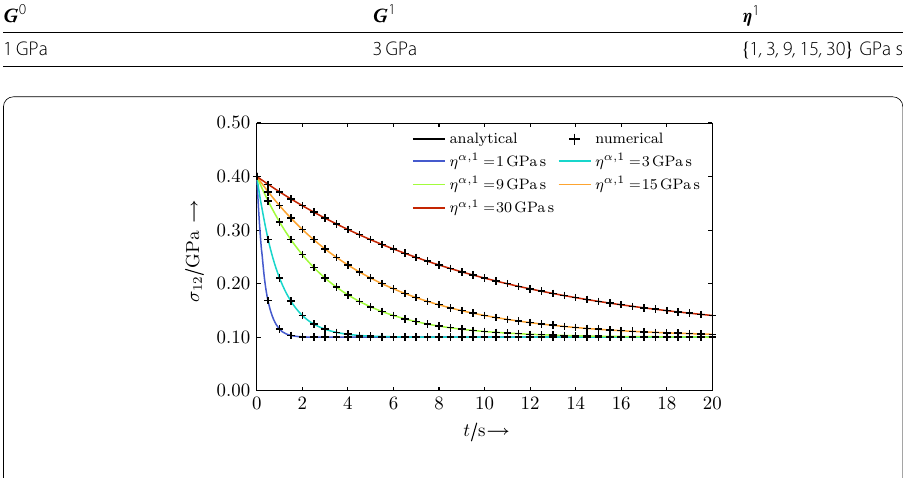
Fig. 2 Standard linear solid: Maxwell-Wiechert model with one Maxwell element Table 1 Relaxation test: Material properties G 0